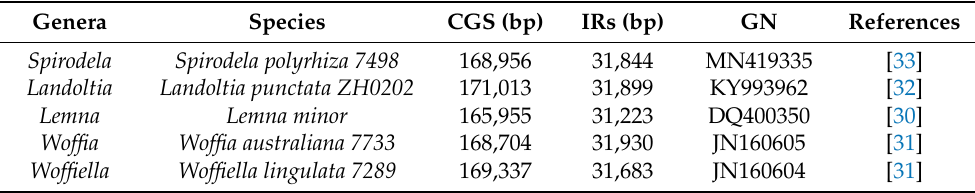
Table 1. Duckweed chloroplast genomes assembly results. Genera Species CGS (bp) IRs